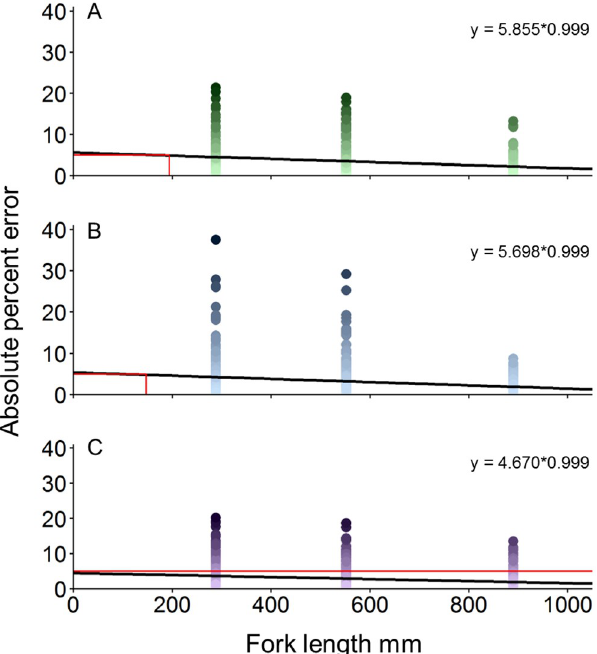
Fig 4. Pool experiment length estimate regression plots. Gamma GLM regressions of absolute percent error estimates versus model fork length for SCs at A) BD1 (406 mm), B) BD2 (610 mm), or C) BD3 (762 mm). Red lines indicate the length at which each regression intersects the a priori specified 5% error threshold, which occurs at 194 mm in A and 147 mm in B. All length estimates were below the error threshold in C.